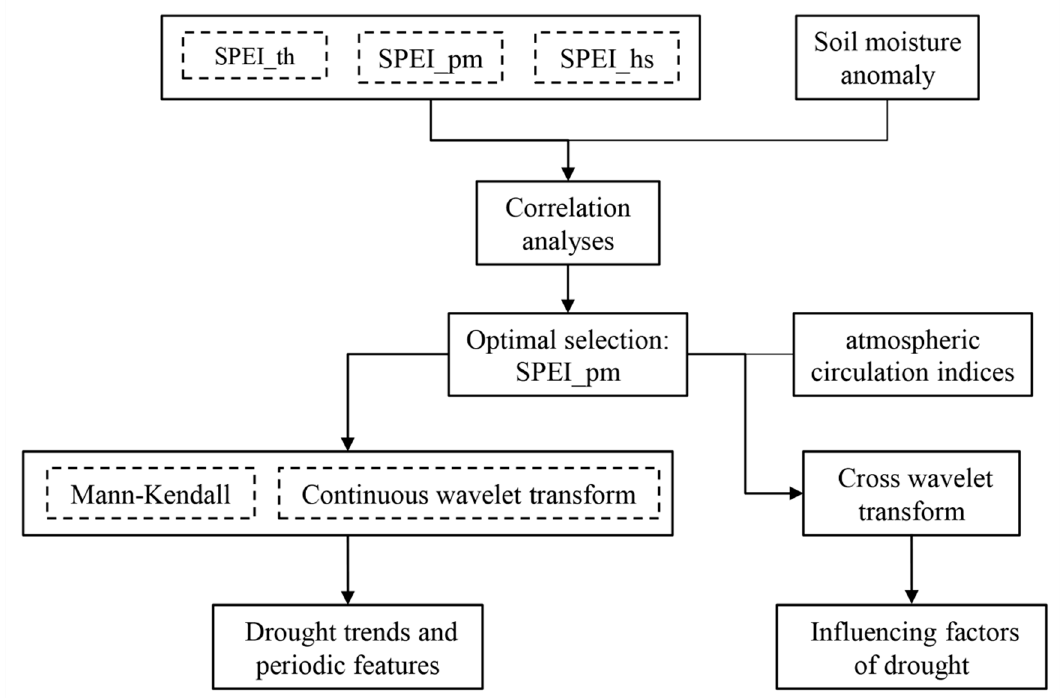
Figure 2. The flowchart of the methodology. Note: The SPEI_th, SPEI_hs, and SPEI_pm represent the PET of SPEI calculated by the TH, HS, and PM equations respectively.